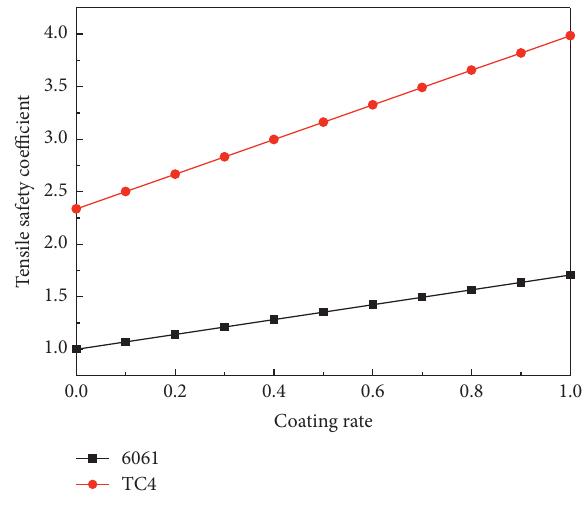
Figure 3: Tensile safety